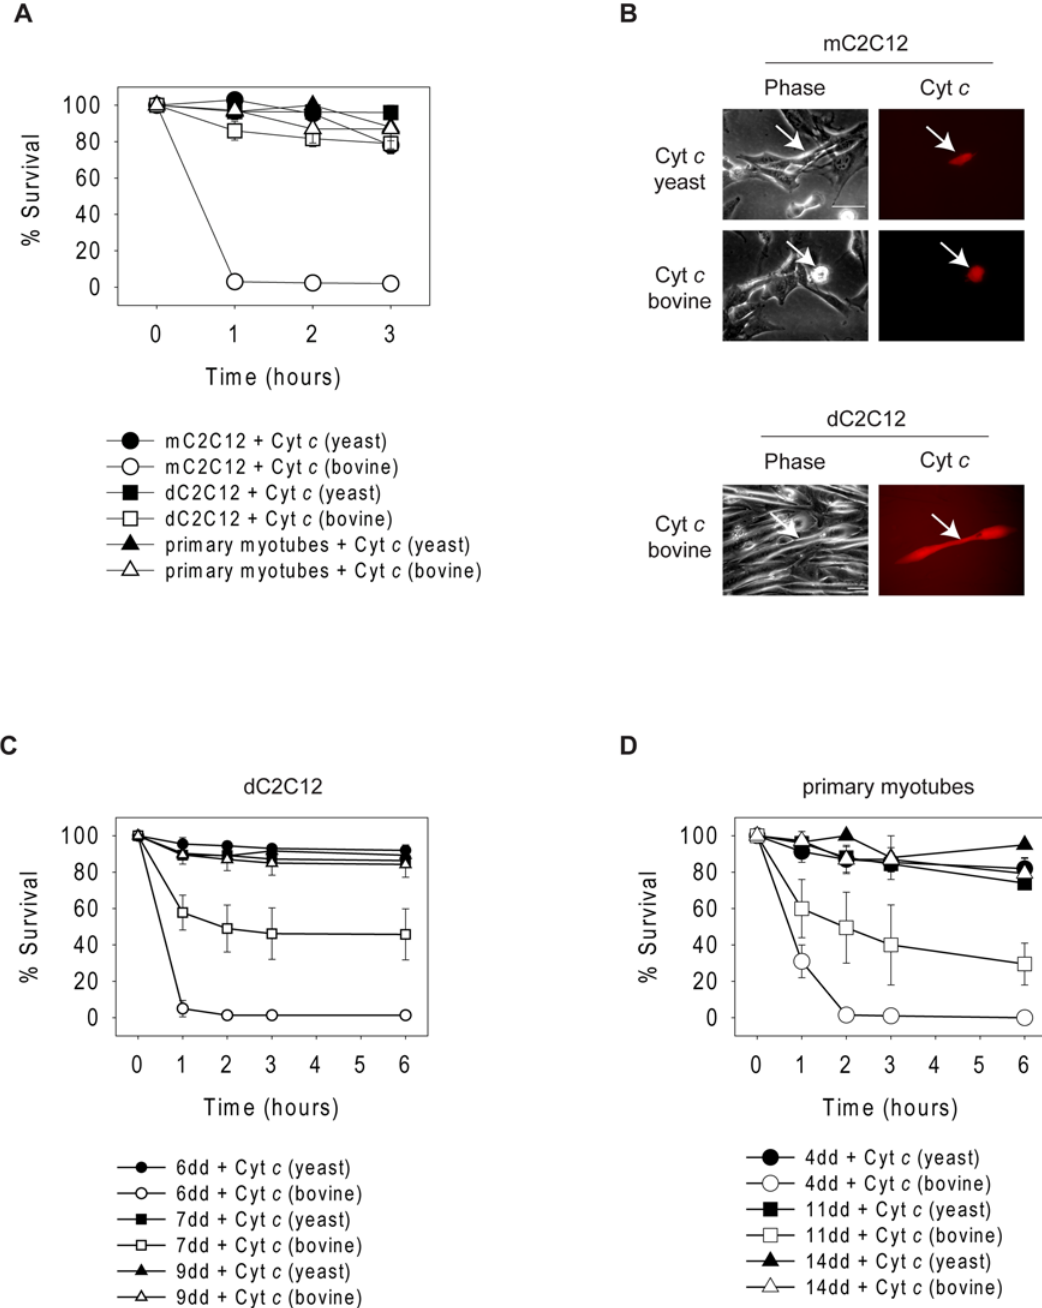
Figure 1. Myotubes develop gradual resistance to cytosolic cytochrome c -induced apoptosis. (A) mC2C12 cells, dC2C12 cells differentiated for 9 days and primary myotubes differentiated for 14 days, were injected with either yeast or bovine cytochrome c and rhodamine dextran. (B) Photographs of mC2C12 and dC2C12 cells one hour following injection with yeast or bovine cytochrome c and rhodamine dextran. Arrows point to injected cells. Scale bars represent 50 m m. (C) C2C12 cells differentiated for 6, 7 or 9 days (dd=days differentiated) were injected with either yeast or bovine cytochrome c and rhodamine dextran. (D) Primary myotubes differentiated for 4, 11 or 14 days were injected with either yeast or bovine cytochrome c and rhodamine dextran. Cell survival was assessed by morphology at the indicated times following injection. Data are the mean 6 SEM of n $ 3 separate experiments per time point.